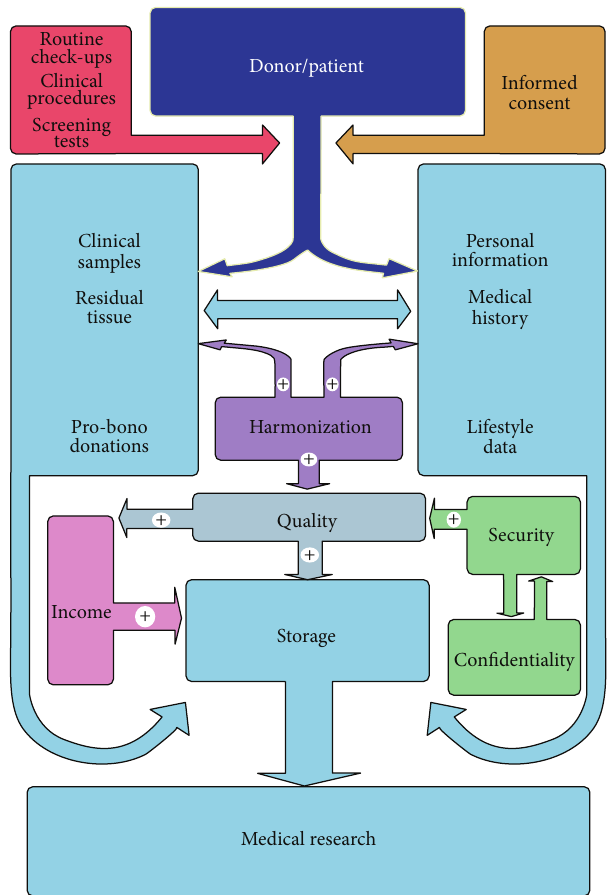
Figure 1: Overview of the circuit of data and samples within a